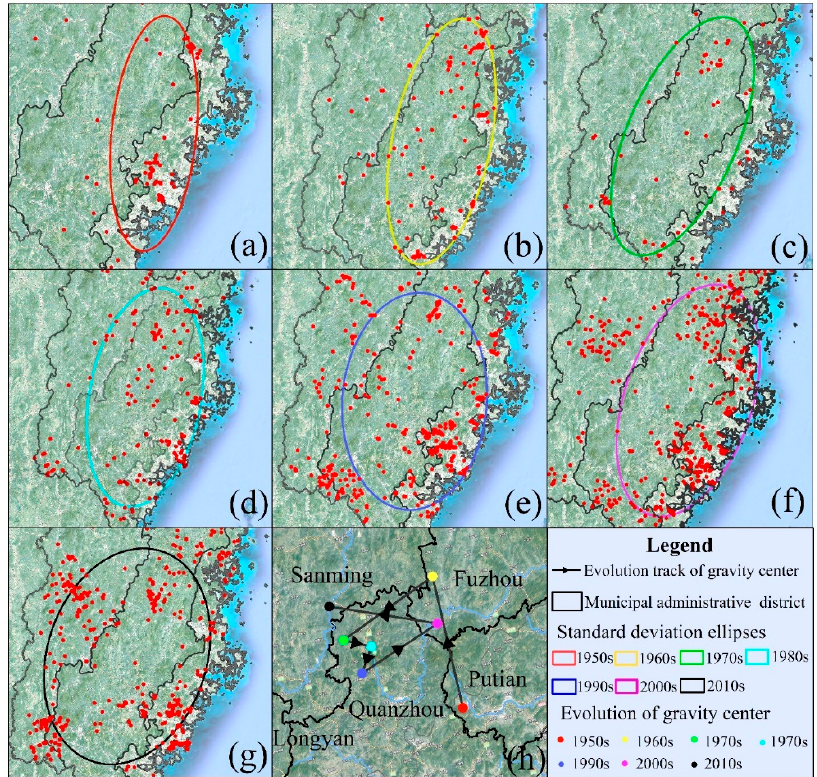
Figure 3. Distribution and gravity center evolution of flash floods during seven periods from the 1950s to the 2010s in Fujian Province. ( a – g ) are the spatial distributions of Fujian’s flash floods represented in the seven periods from the 1950s to the 2010s. ( h ) is the evolution track of the gravity center.